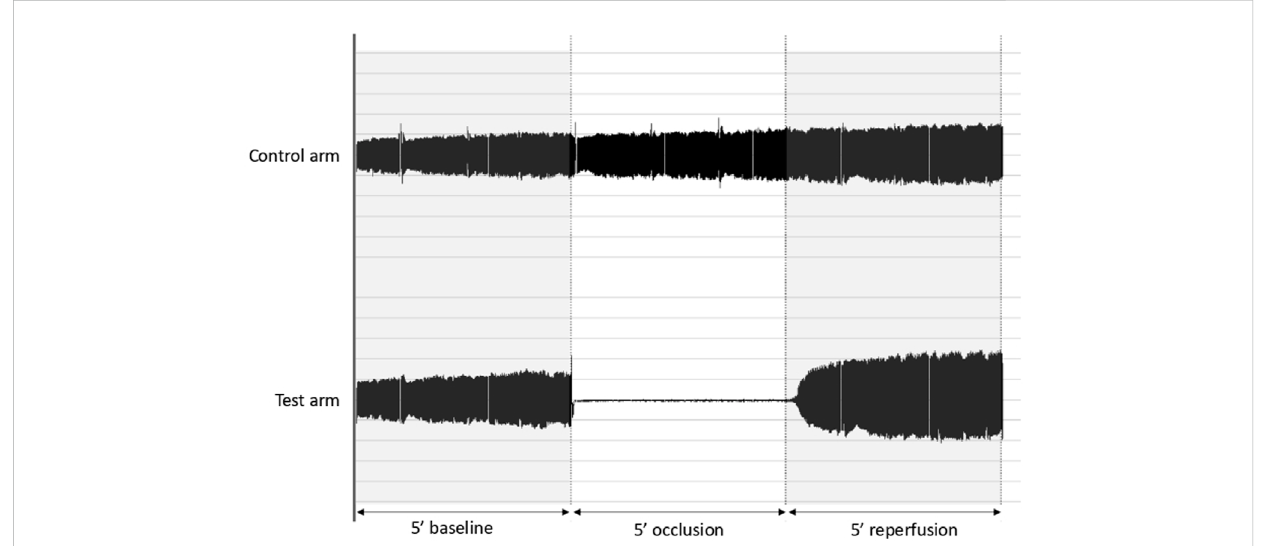
FIGURE 1 Typical signals obtain during the vascular function evaluation. After 5 min baseline measurement, a blood pressure cuff on the test arm was in fl ated for 5 min. After 5 min occlusion, the cuff was de fl ated, and the signal recorded for 5 min of reperfusion.